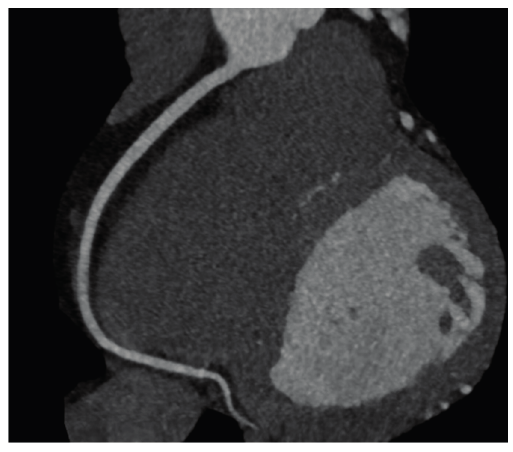
Figure 6. Normal right coronary